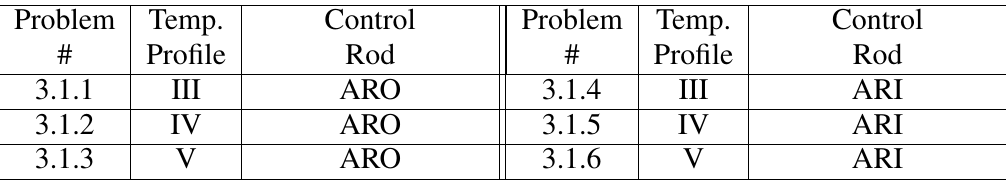
Table 4: Natural Uranium Quarter Core BOC